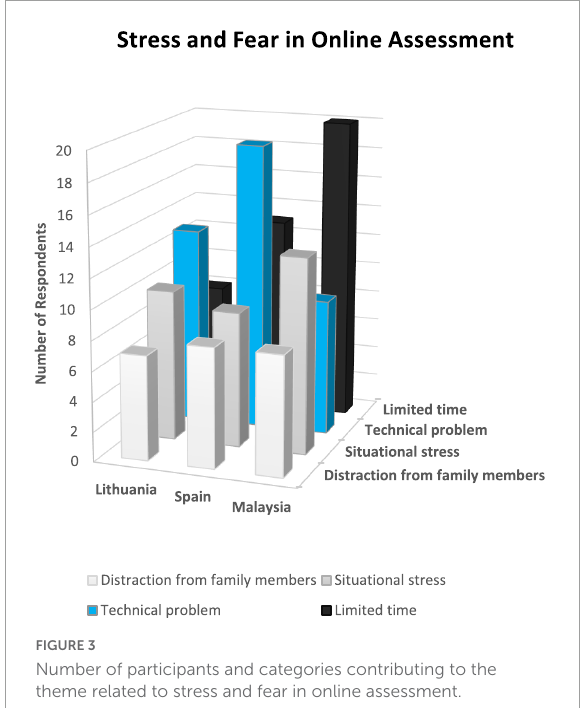
FIGURE3 Number of participants and categories contributing to the theme related to stress and fear in online